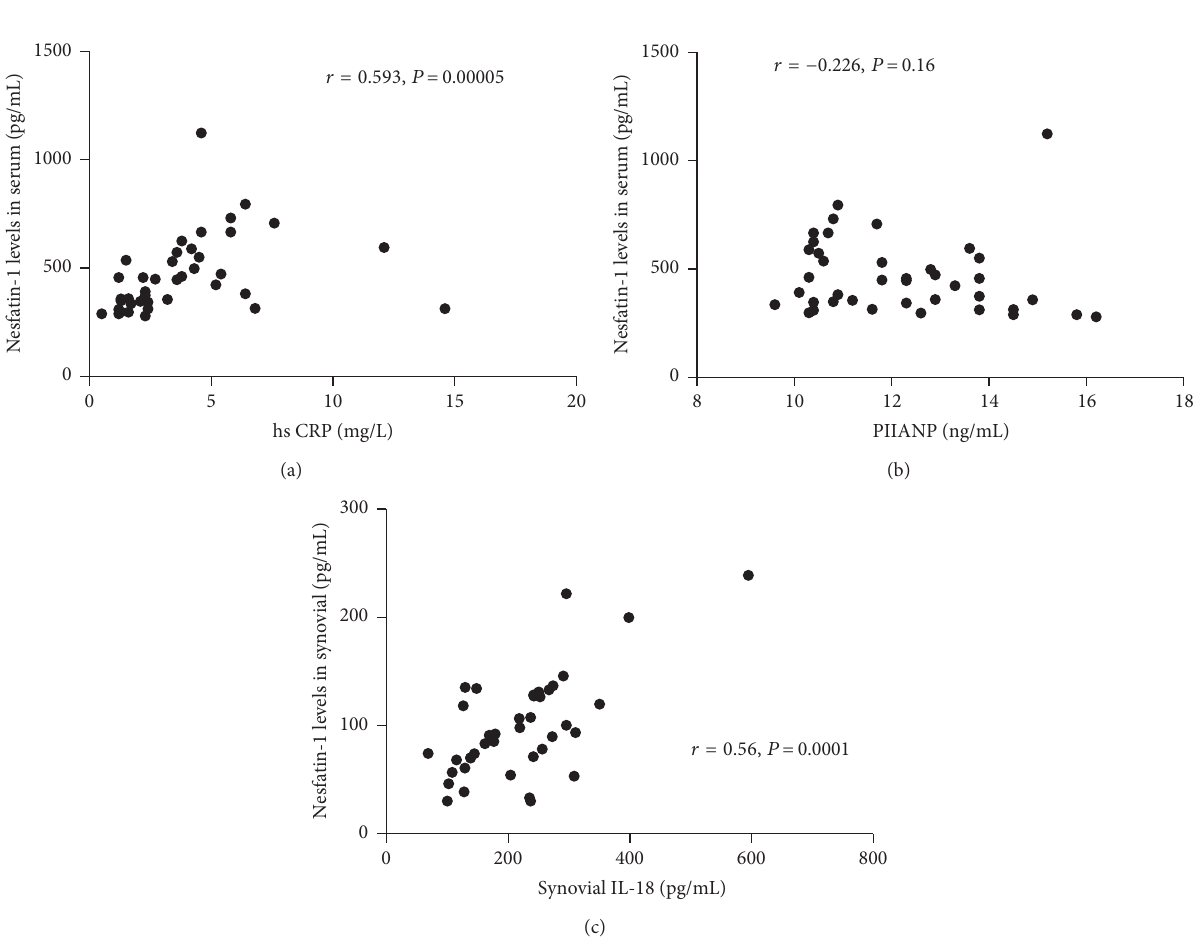
Meanwhile, the nesfatin-1 levels in synovial, respec- tively, were 88.65 ± 42.7 (BMI ≦ 25 ), 116.10 ± 55.71 ( 25 < BMI ≦ 30 ), and 99.66 ± 46.86 (BMI ≧ 30 ).